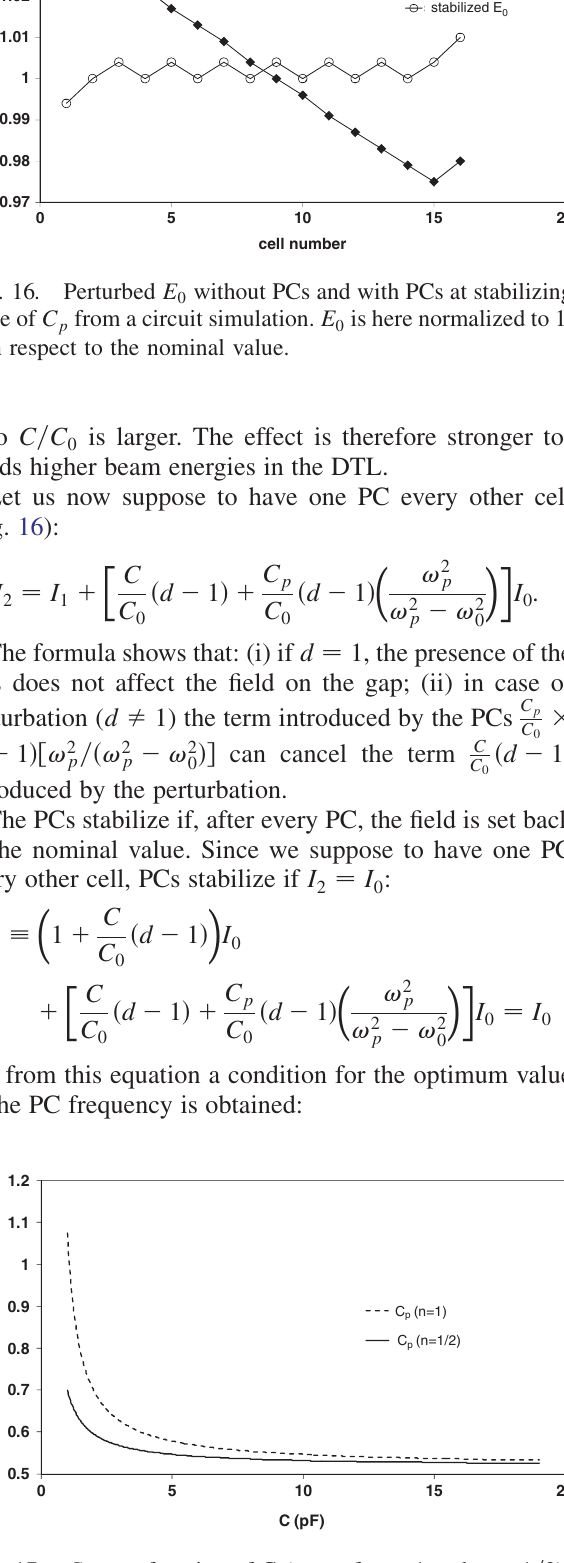
FIG. 17. C as a function of C (case of n ¼ 1 and n ¼ 1 = 2 ). p